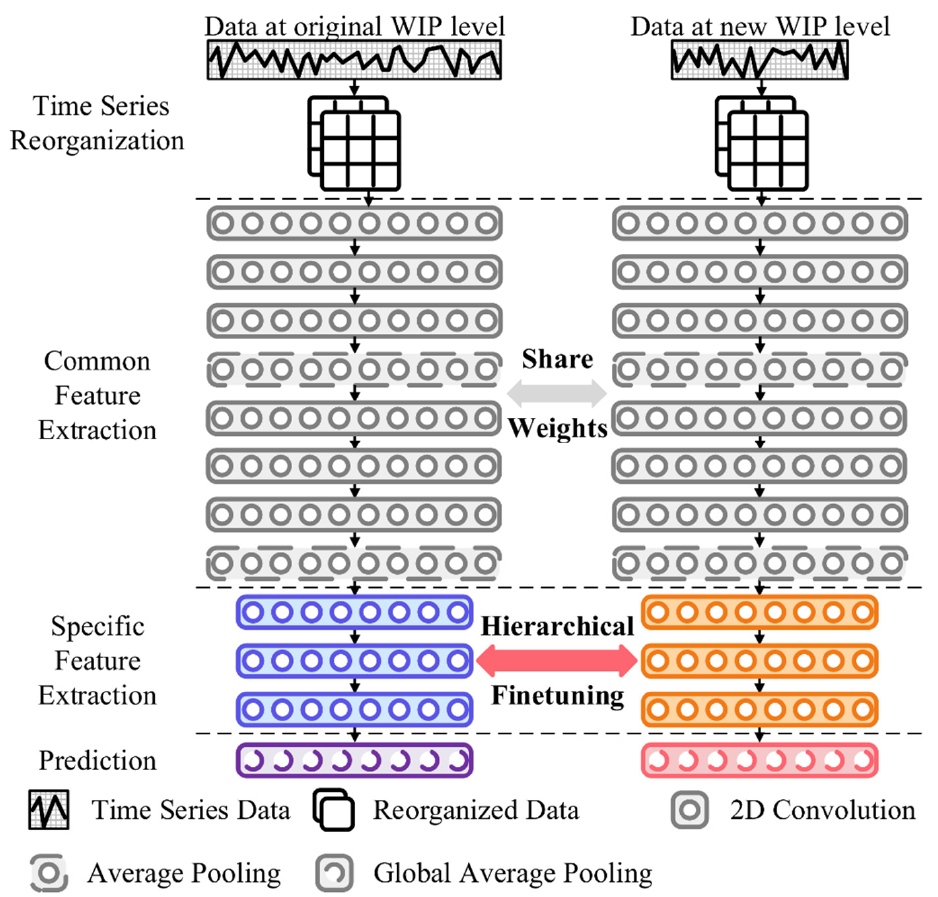
Figure 2. Architecture of the proposed hierarchical finetuning transfer network.